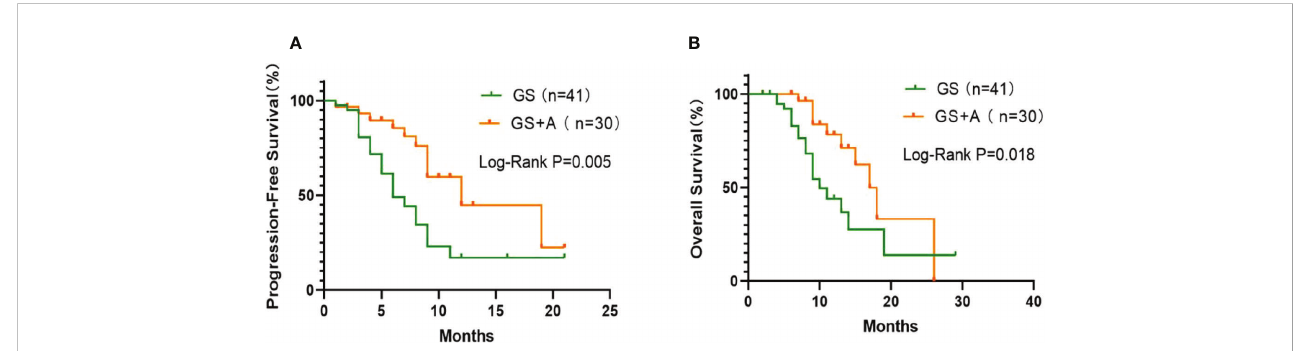
FIGURE 1 Kaplan-Meier plots: The GS+A group exhibited longer median progression ‐ free survival (mPFS; (A) and median overall survival (mOS; (B) than the GS.